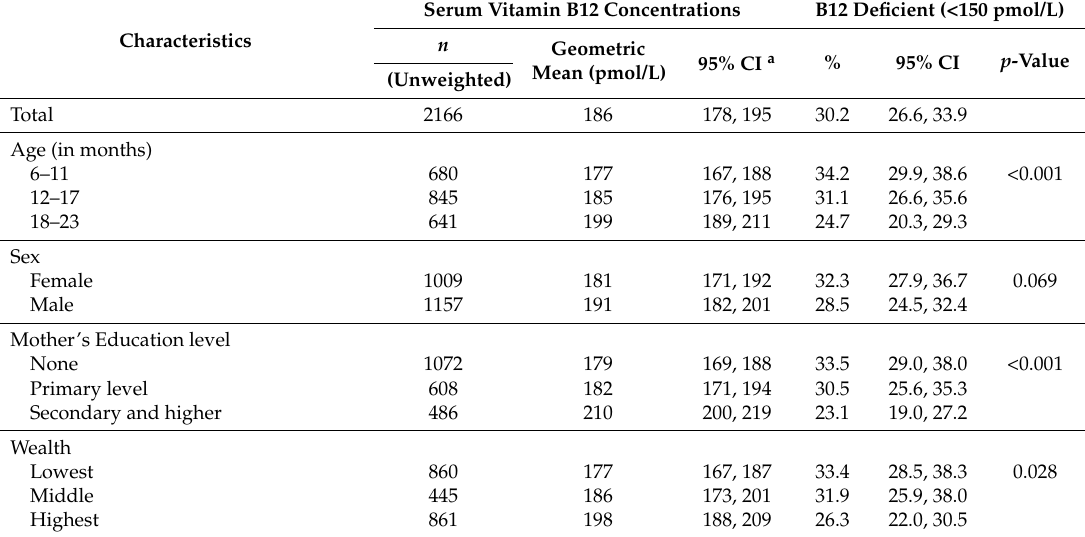
Table 1. Serum vitamin B12 concentrations among children aged six to 23 months by socio-demographic and nutrition variables, Kapilvastu and Accham districts, Nepal,